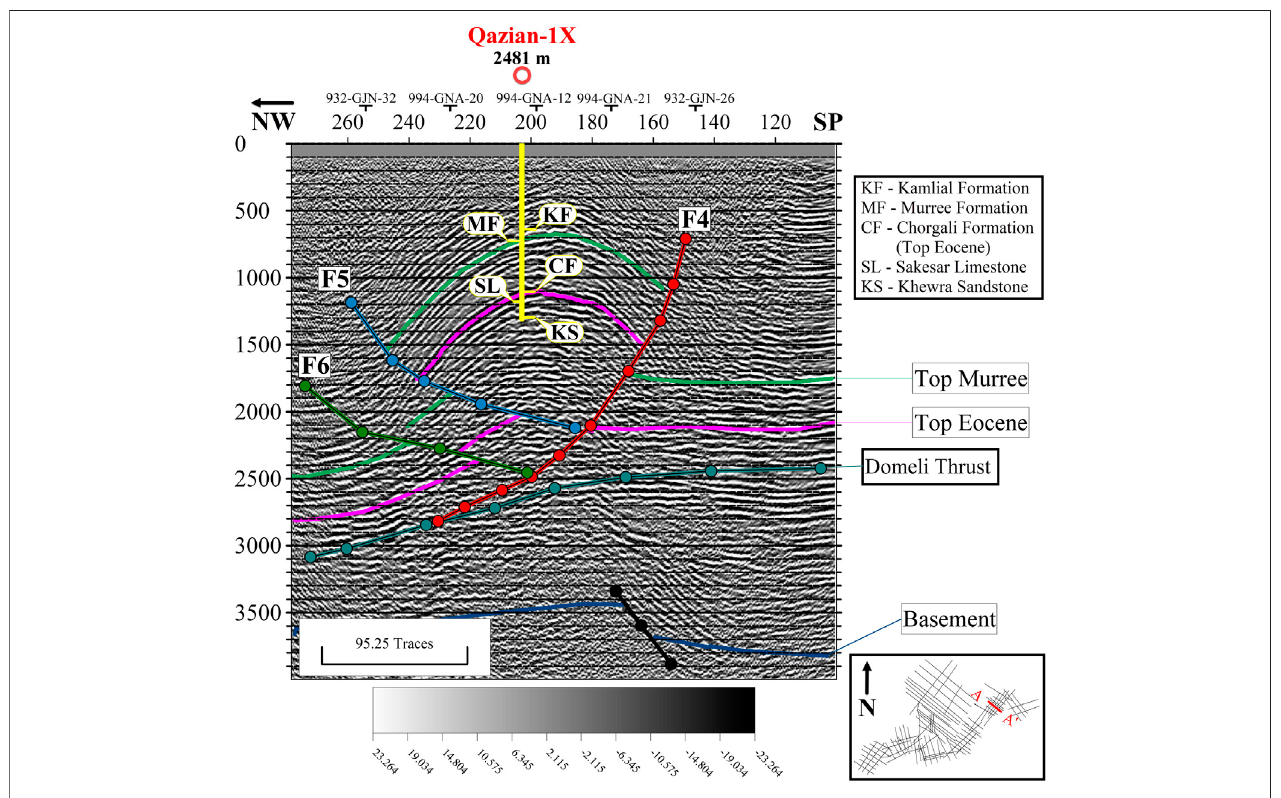
FIGURE 5 | Interpreted seismic section of line 994-GNA-09 of Qazian fi eld (zone-1). Structural geometry shows repeated thrust sheets with a pop-up structure bounded by faults F4 and F5 on the top sheet. Qazian-1X well is drilled on the pop-up anticlinal structure formed by F4 and F5 faults.